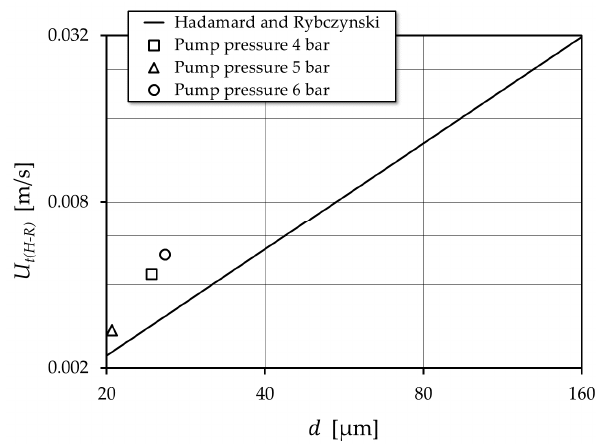
Figure 12. Terminal rise velocity with respect to microbubble diameter.